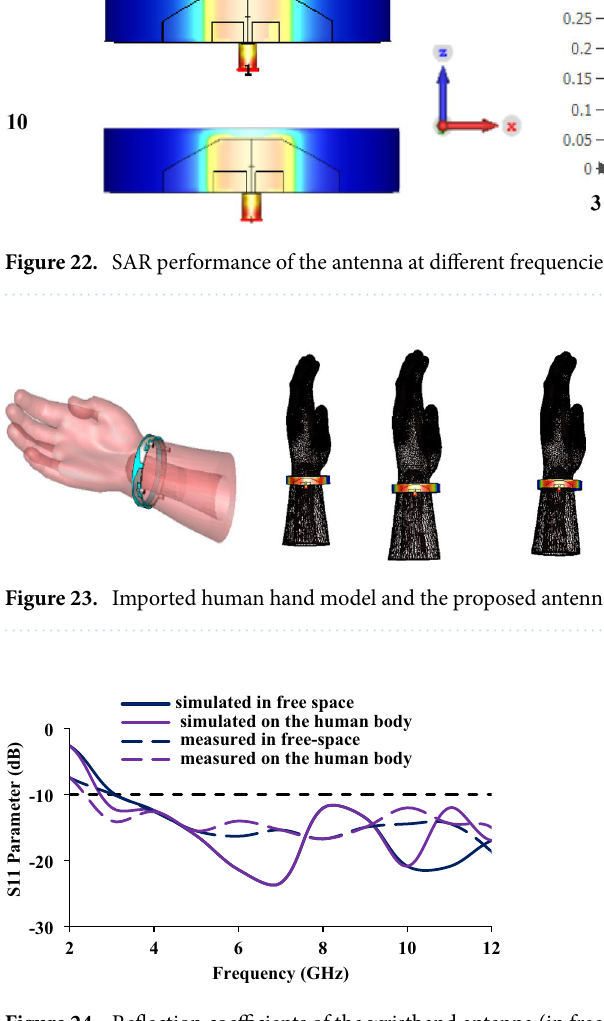
Figure 24. Reflection coefficients of the wristband antenna (in free space and on the human